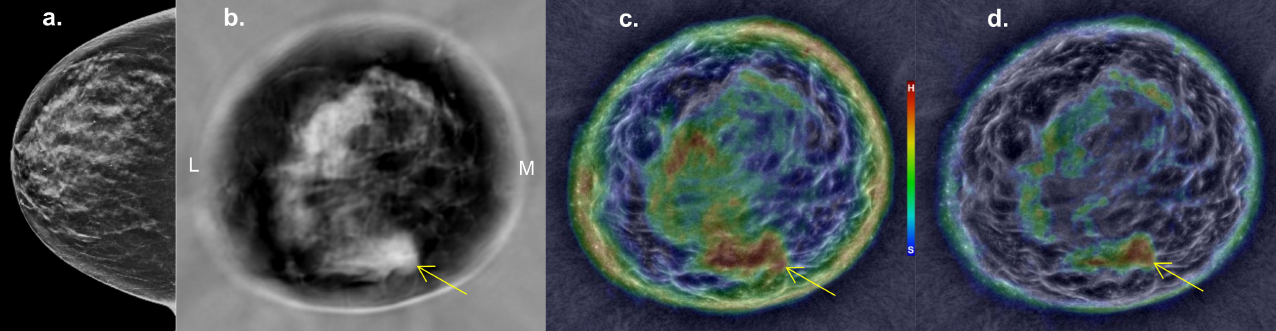
Figure 4. Cancer patient : Breast imaging from a woman with heterogeneously dense breasts showing her unremarkable right mammogram in cranio-caudal (CC) projection ( a ), mid-breast sound speed image ( b ), unfiltered ( c ) and filtered ( d ) stiffness images. Mass localization from SoftVue images is similar to coronal MR, whereby the upper portion of the image is superior (e.g., 12:00) and medial (M) for this right breast mass, also defined by the ~5:00 position used in standard US. The unfiltered stiffness image ( c ) shows a larger red area at 5–6:00 that partially obscures the underlying mass effect from the cancer (arrows) at 5:00, better seen on sound speed ( b ) and filtered stiffness ( d ) images. Abbreviations: On color bar in part C and D, H = hard, S = soft; italics filtered = non-standard stiffness fusion